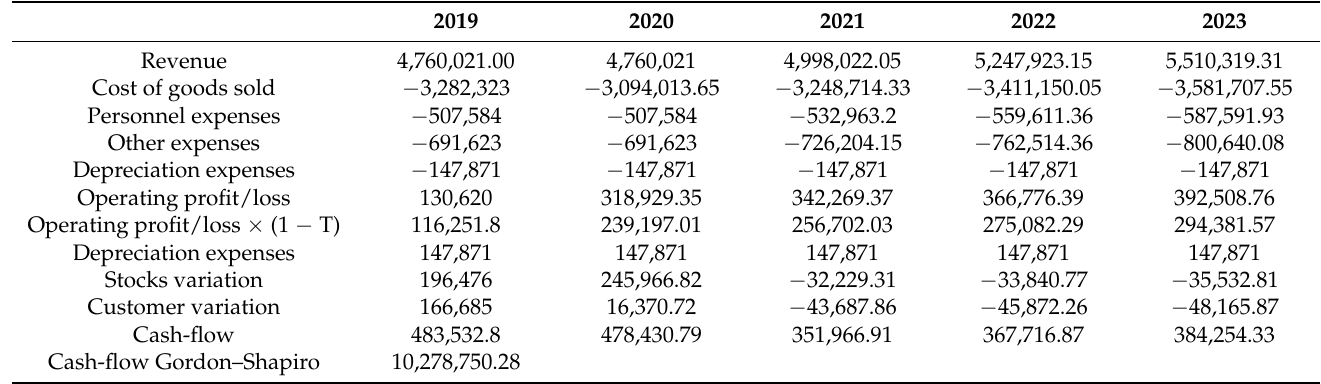
Table 2. Cash flow projection for a five-year time horizon ( €